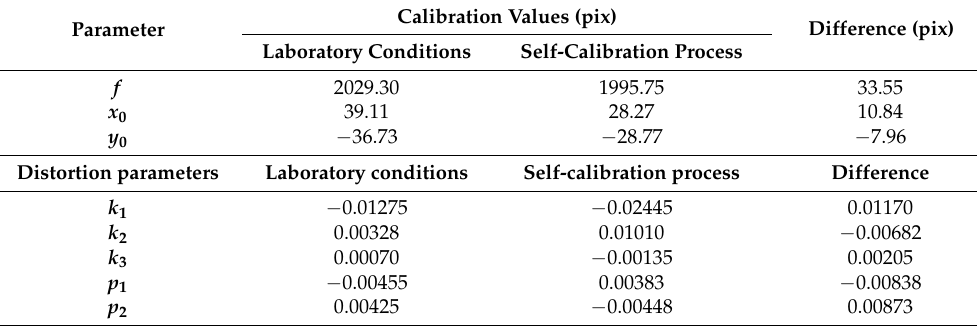
Table 3. Comparison of camera calibration